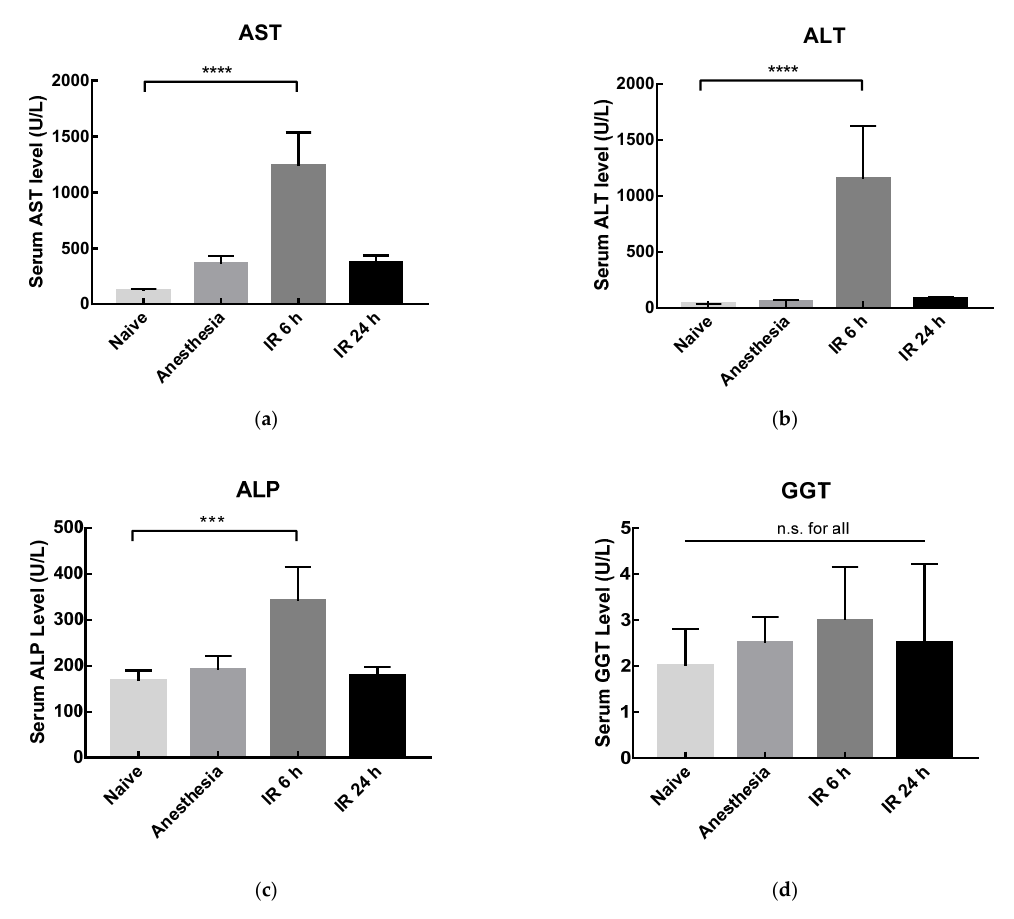
Figure 9. Serum AST ( a ), ALT ( b ), ALP ( c ), and GGT ( d ) levels in rats from naïve, sham anesthesia, or IR groups. Rats were sacrificed 6 h (IR 6 h) or 24 h (IR 24 h) after the reperfusion onset. Results are presented as mean ± SD ( n = 4). *** p < 0.001 and **** p < 0.0001 compared with naive group; n.s., statistically non-significant compared with naive group. In addition to the hepatic damage, the inflammation progression in the rodent model is also an important parameter to follow. According to the mRNA expression levels depicted in Figure 10, 6 h was the most adequate end-time point for TNF- α mRNA the IR group compared with the naive group, a feature that characterizes inflammatory conditions [43–46].